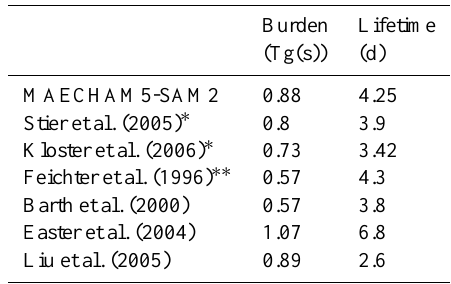
Table 2. Comparison of sulphate aerosol burden and lifetimes from this and other climate model